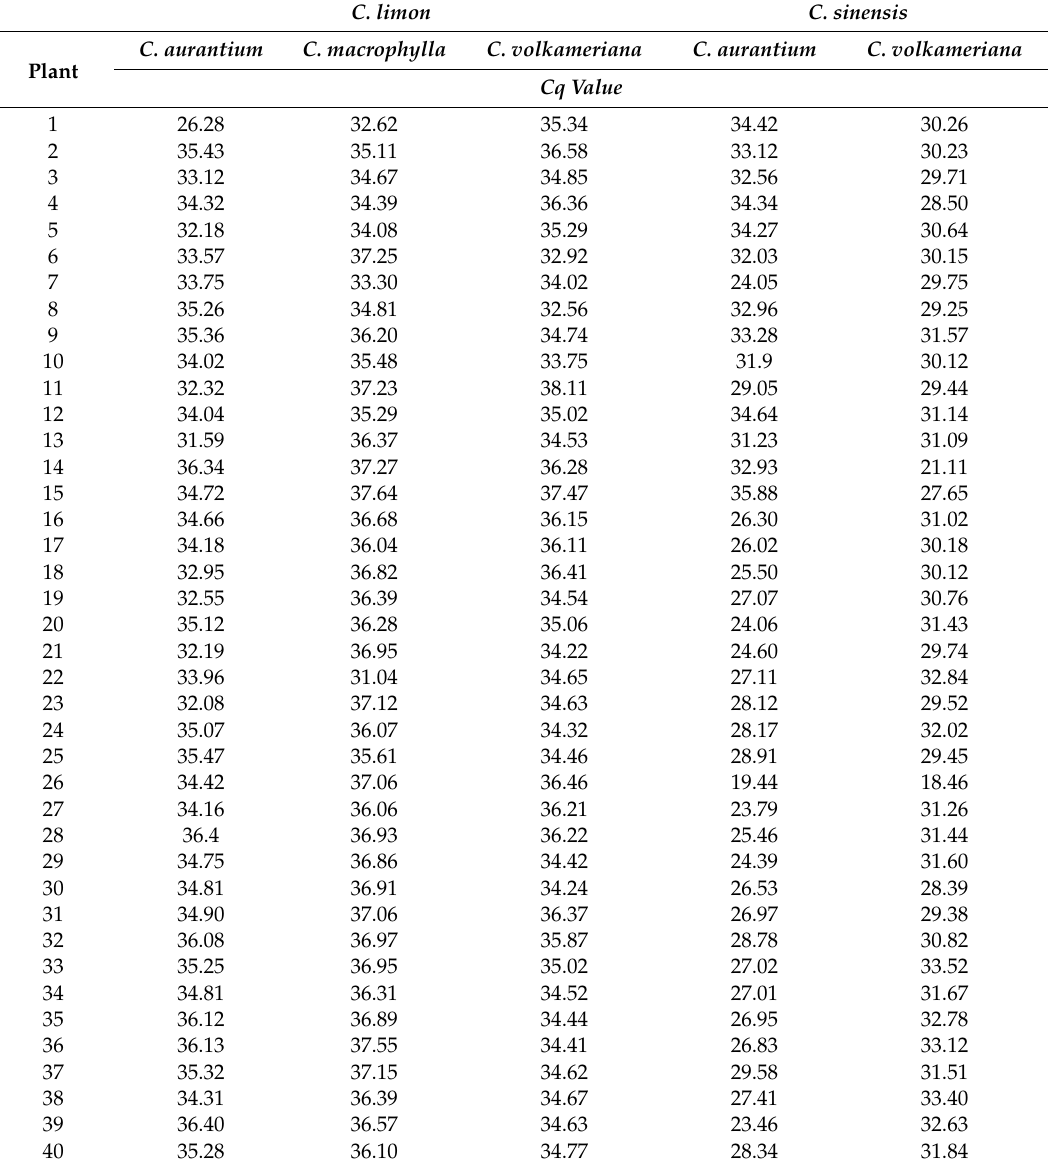
Table 1. Values of the quantification cycle (Cq) of the bacterium Candidatus Liberibacter asiaticus in foliar samples of Citrus limon and Citrus sinensis developed in di ff erent